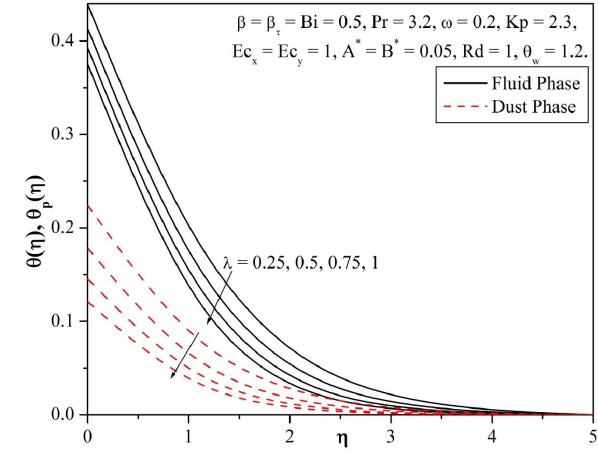
Fig. 7: Dimensionless temperature profiles for different values of λ